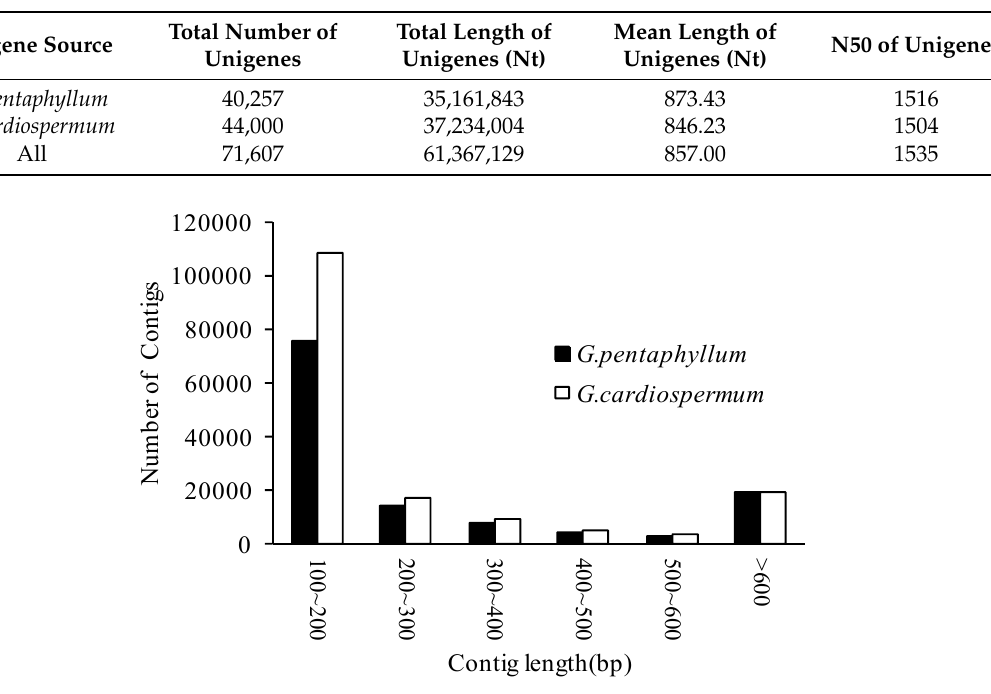
Figure 1. Frequency distribution of the contig sizes from two Gynostemma species. The frequency distribution of contig sizes resulting from Illumina HiSeq™ 2000 sequencing, as assembled using Trinity.